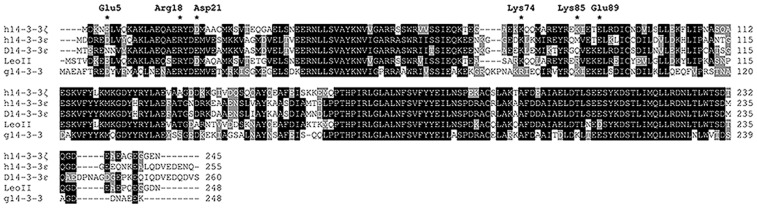
Multiple Sequence alignment of 14-3-3 proteins.
Homo sapiens 14-3-3epsilon (h14-3-3ε, accession number P62258.) and 14-3-3zeta (h14-3-3ζ, P29312); Drosophila melanogaster D14-3-3epsilon (D14-3-3ε, P92177) and Leonardo II (LeoII, P29310-2); Giardia duodenalis 14-3-3 (g14-3-3, AAZ91664.1). Invariant or conserved amino-acids are boxed in black, those conserved in at least two proteins are highlighted in gray and divergent ones are left unboxed. Dashes indicate gaps. Stars indicate residues that in the human 14-3-3zeta form salt bridges involved in N-terminal dimerization (Arg18-Glu89, Glu5-Lys74, and Asp21-Lys85).